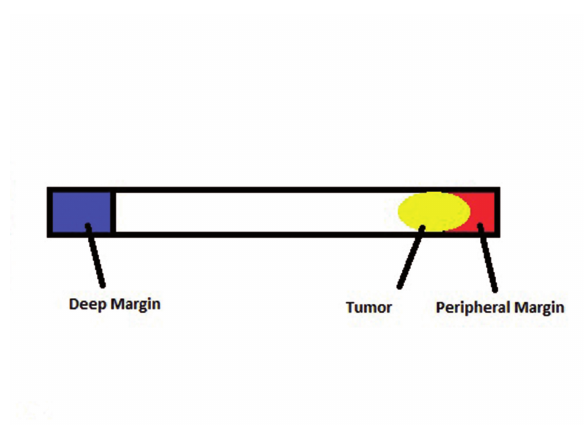
Figure 4 - Example of tumor distance from end of dyed